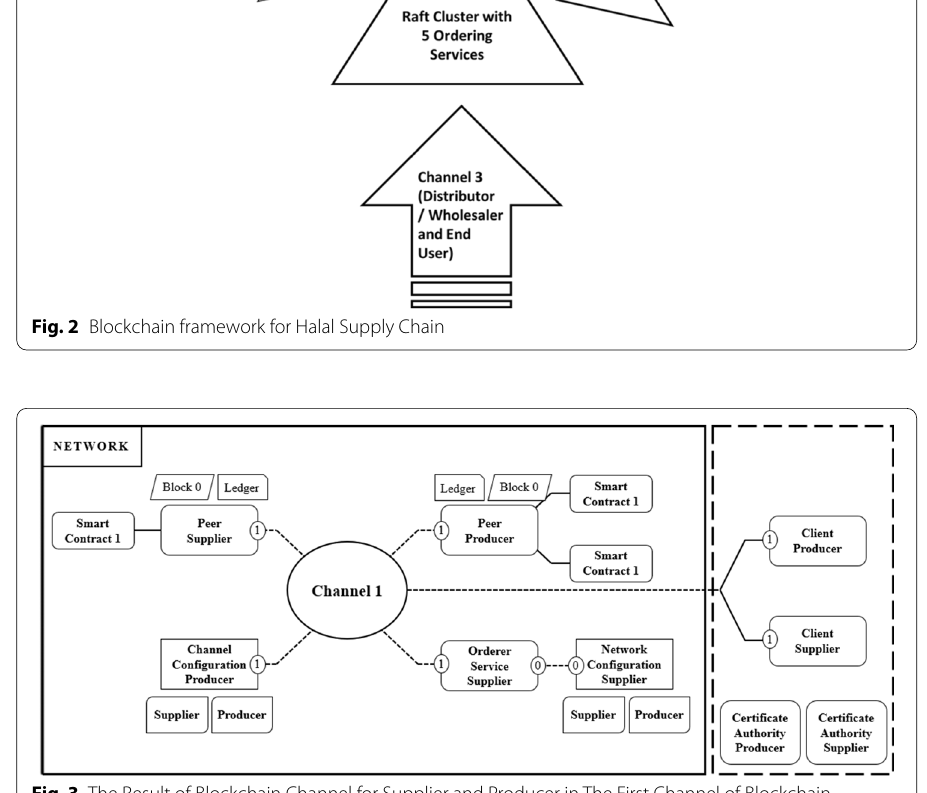
Fig. 3 The Result of Blockchain Channel for Supplier and Producer in The First Channel of Blockchain Network